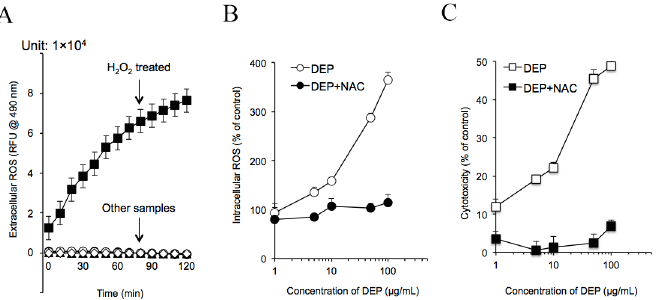
Fig 1. DEPs induced intracellular ROS generation in capillary-like tube cells and caused cytotoxicity. (A) DEPs were incubated in the cell-free system for 2 h. Cm-H 2 DCFDA assays were then carried out. ROS production is shown for each sample. (B) HUVECs were exposed to DEPs ± NAC for 24 h. Intracellular ROS is shown. (C) Tube cells were exposed to DEPs with or without the addition of NAC. Cytotoxicity was measured as described in the Methods.